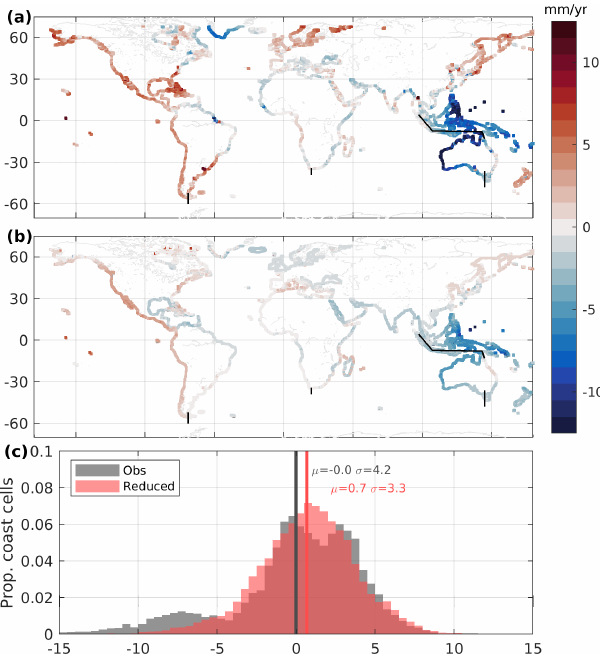
Figure 5. Comparison of 2008–2018 trend anomaly (mmyr − 1 ) from satellite altimetry and the reconstruction. The observed decadal trend in satellite altimetry with the global mean removed (a) and the reconstructed decadal trend for each basin and com- ponent combined (b) , with a histogram (c) for all coastal grid cell locations for observations from satellite altimetry (grey) and the al- timetry minus the reconstruction (so-called “reduced” trends, red).